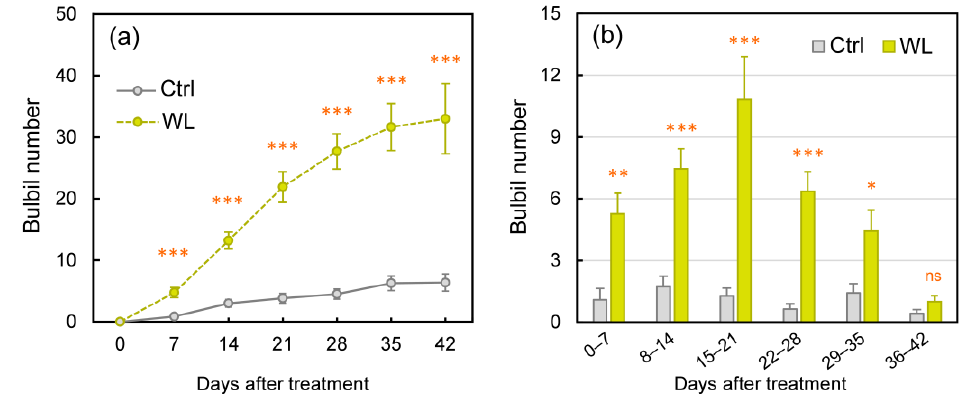
Figure 1. Changes in formed bulbil number under control (Ctrl) and waterlogged (WL) soil condi- tions. ( a ) Total bulbil number and ( b ) number of formed bulbils every seven days. Values are the means ± S.E. of 7 – 11 replications derived from different plant. * p < 0.05, ** p < 0.01, *** p < 0.001; ns, not significantly different (Student’s t -test).